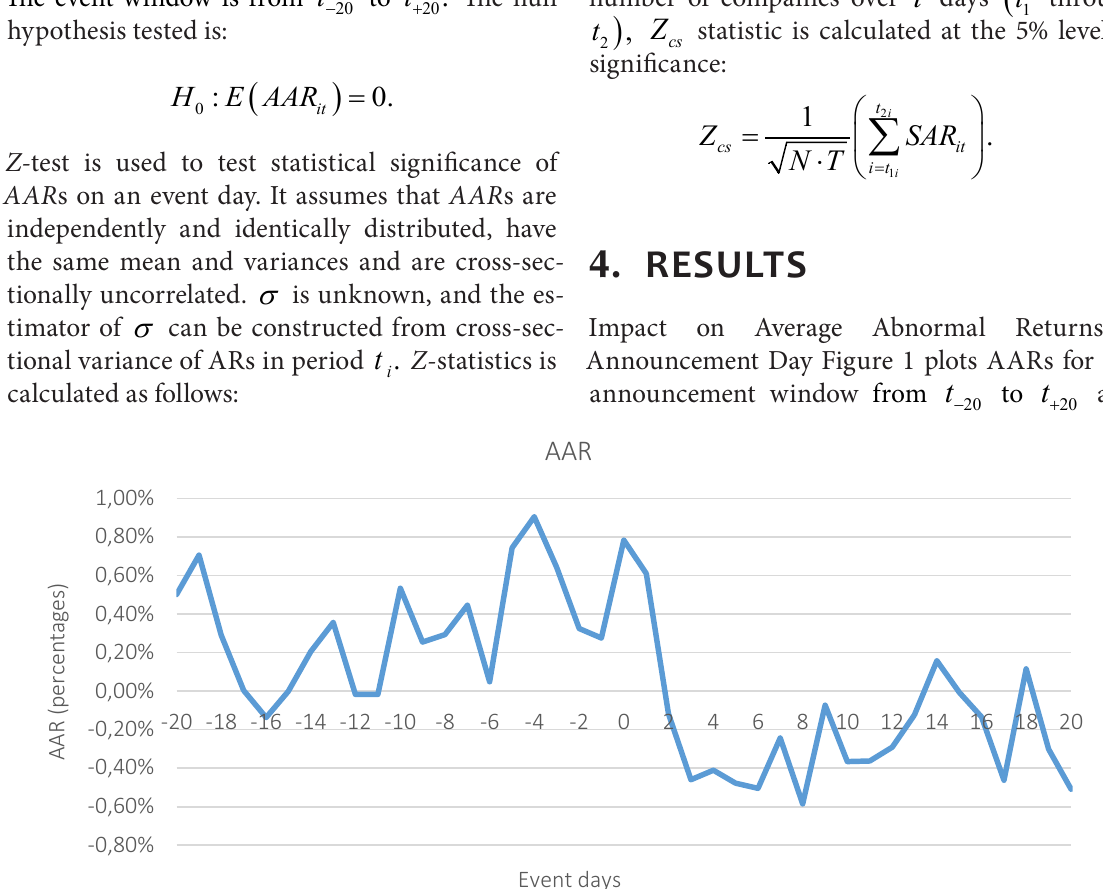
Figure 1. Average abnormal returns (announcement